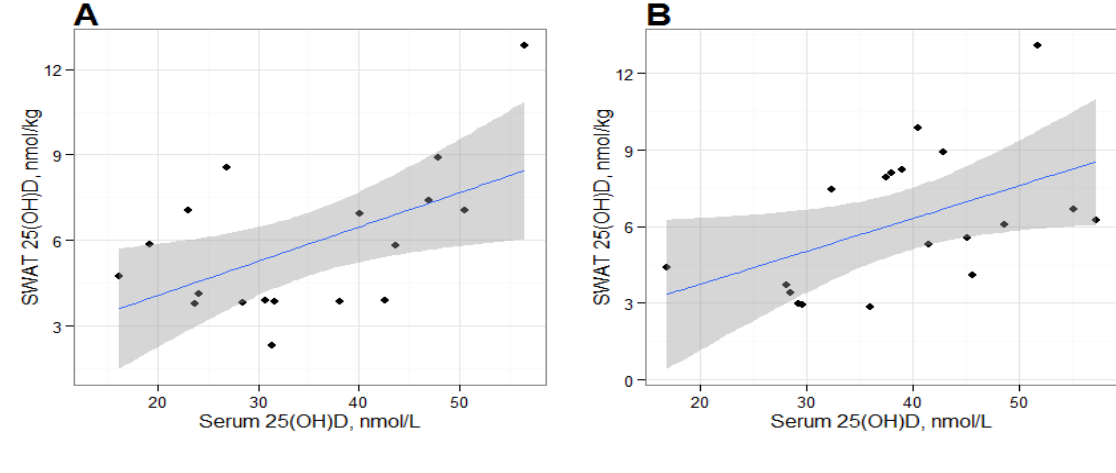
Figure 3. Association between Subcutaneous White Adipose Tissue and Serum 25(OH)D at ( a ) Baseline and ( b ) Post-Intervention following a 15 week weight loss regimen in adults. Shaded area = 95% Confidence